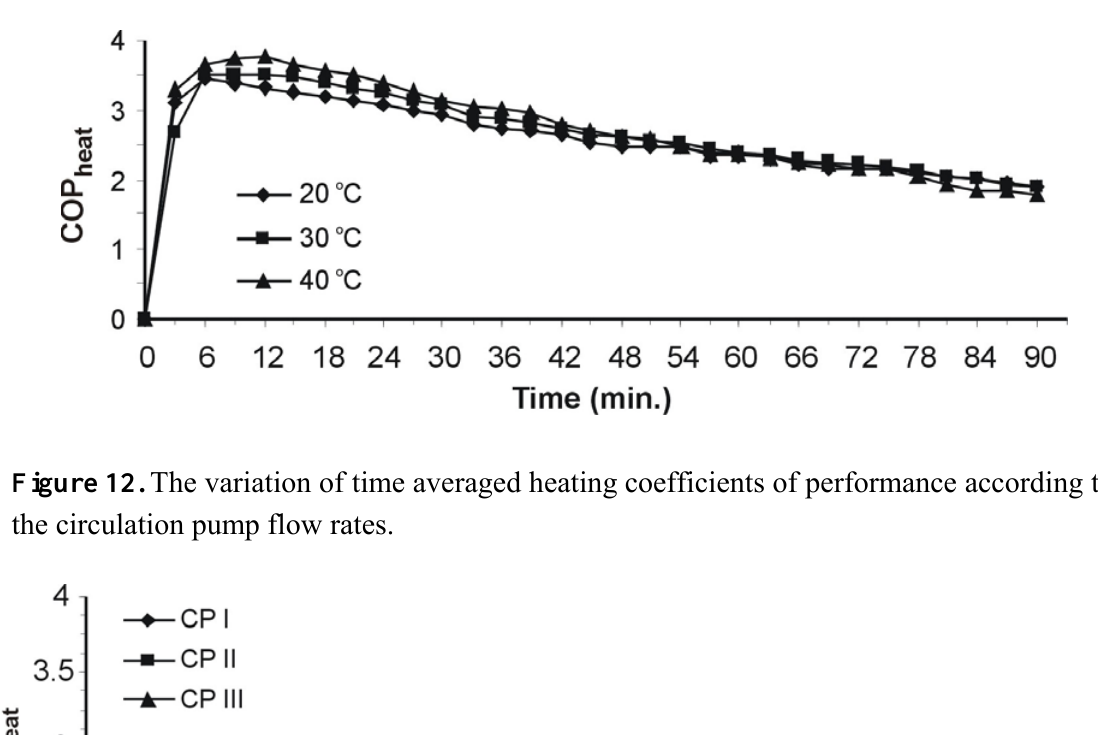
Figure 11. The variation of the heating coefficients of performance at the different waste water temperatures for the circulation pump flow rate CP III during the experiment.